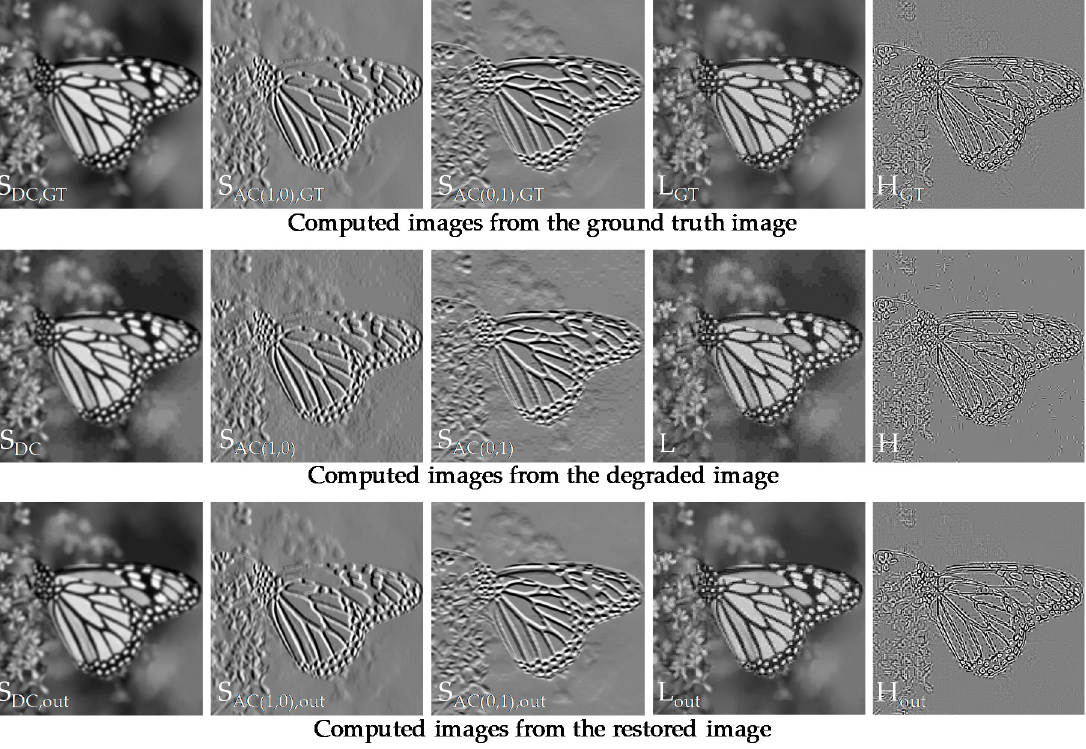
Algorithm 1: Compressed Poisson noise reduction based on the SCENet